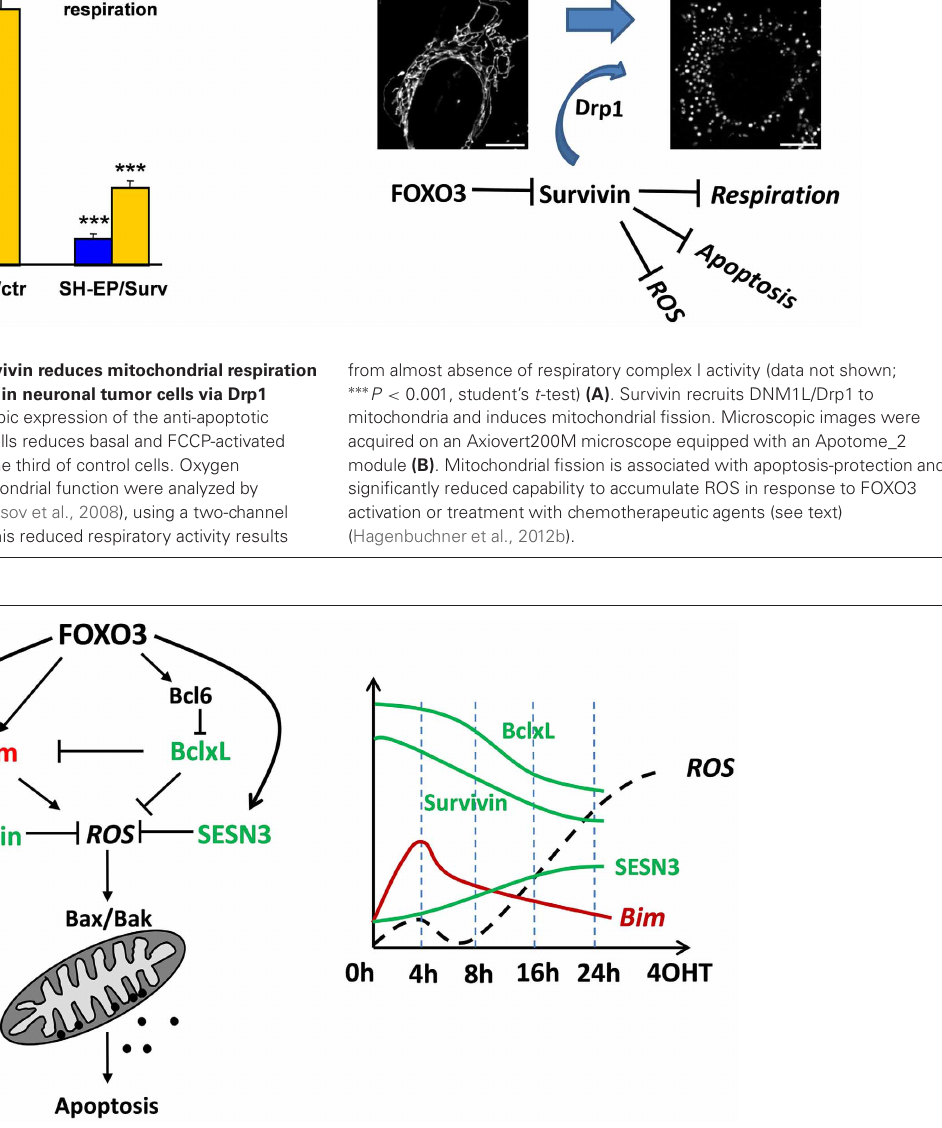
with apoptosis-inducing signals. This concerted regulation of pro- and anti-apoptotic ROS-affecting proteins overcomes the protective effect of SESN3 after about 16h leading to a sharp and continuous increase in ROS, which finally leads to apoptotic cell death. The schematic presentation is based on several time-course immunoblot experiments and data from fluorescence-based mitochondrial ROS measurements not included in this